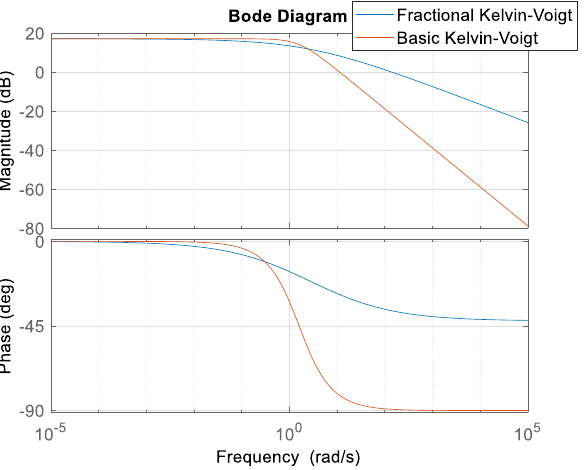
Figure 4. Difference in Bode diagrams of the fractional and the basic Kelvin–Voigt model.